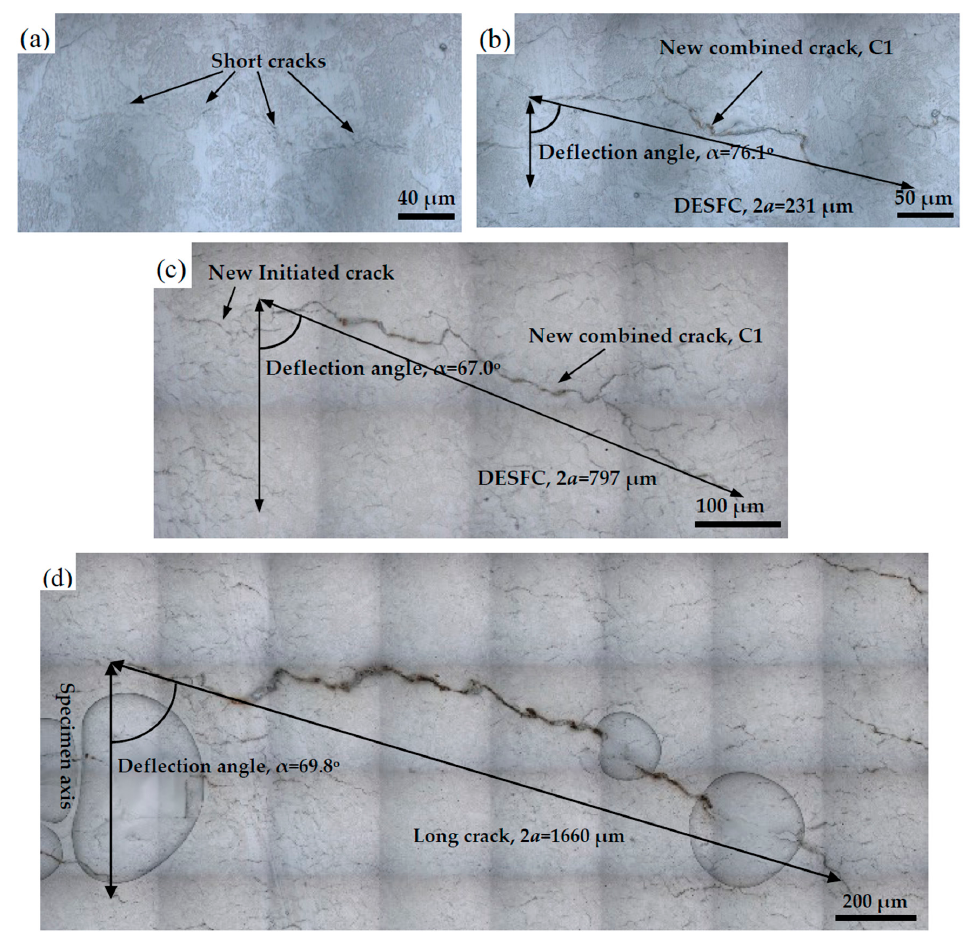
Figure 8. Images of fatigue crack under different cycles: ( a ) N = 3000 cycles, ( b ) N = 115,000 cycles, ( c ) N = 13,000 cycles, and ( d ) N = 15,000 cycles.